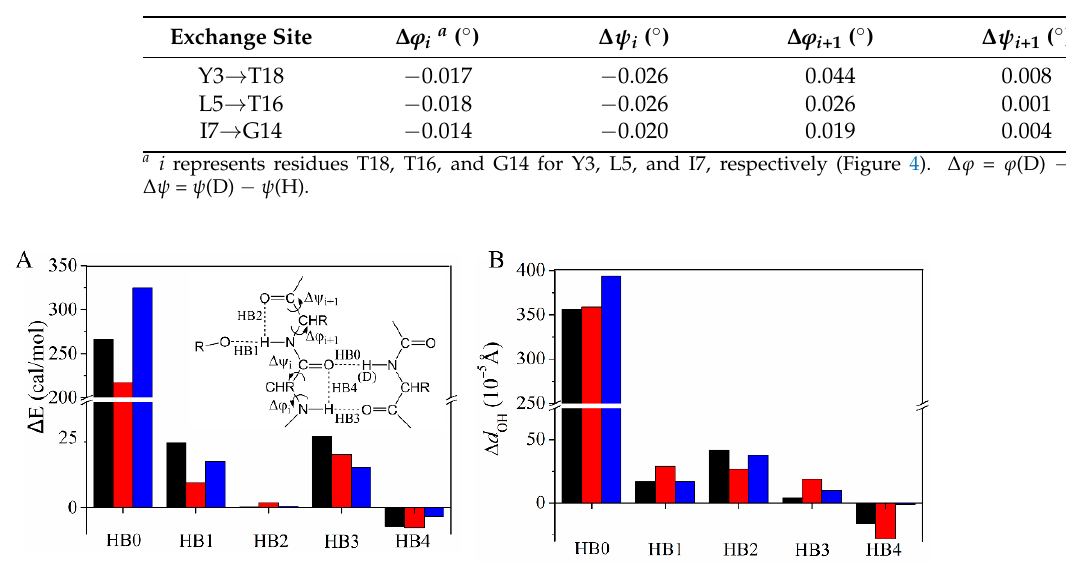
Figure 4. Changes of the H-bond energy Δ E ( Δ E = E (D) − E (H) ( A ) and the H-bond distance between H of the donor and O of the acceptor ( B ) when substituting N–H by N–D for Y3 (black), L5 (red), or I7 (blue). HB0 and HB3 are between β 1 and β 2 whereas HB2 and HB4 (so called “C5 H-bond”) are within β 2. HB1 is the H-bond formed between the amide and the side chain (NH of T17 with O γ H of T16; NH of K19 with O γ H of T18) or water (NH of E15 with OH of water) (Figures S5–S7).